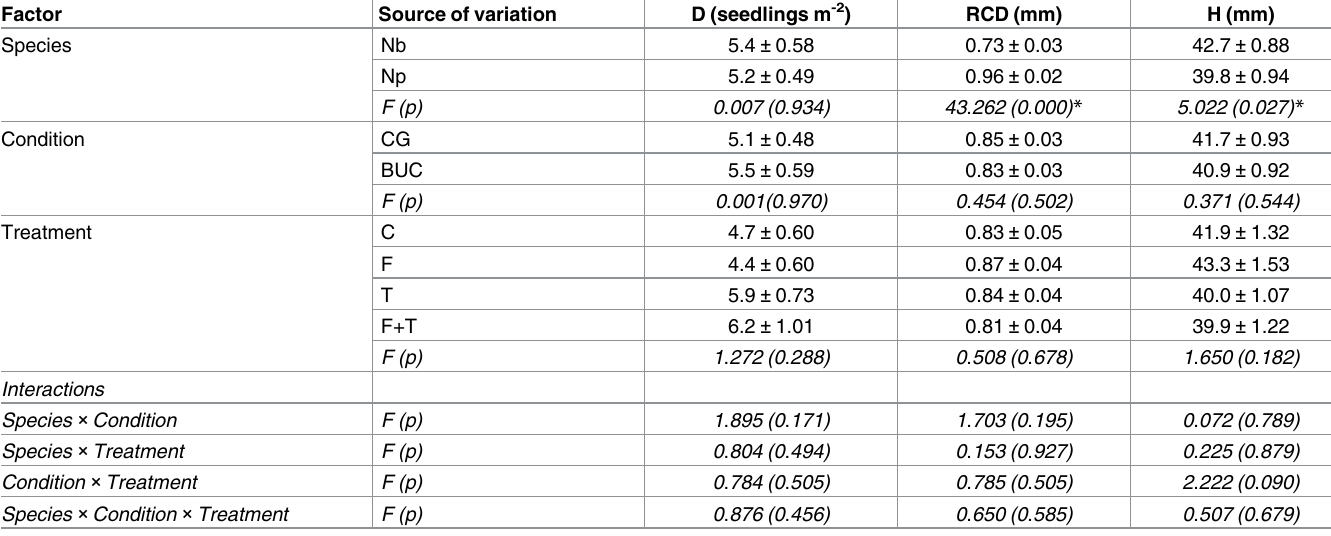
Table 2. Three-way ANOVA for mean ( ± SE) initial density (D), initial root collar diameter (RCD) and initial height (H) of seedlings per plot by spe- cies, canopy condition and treatment as main factors.